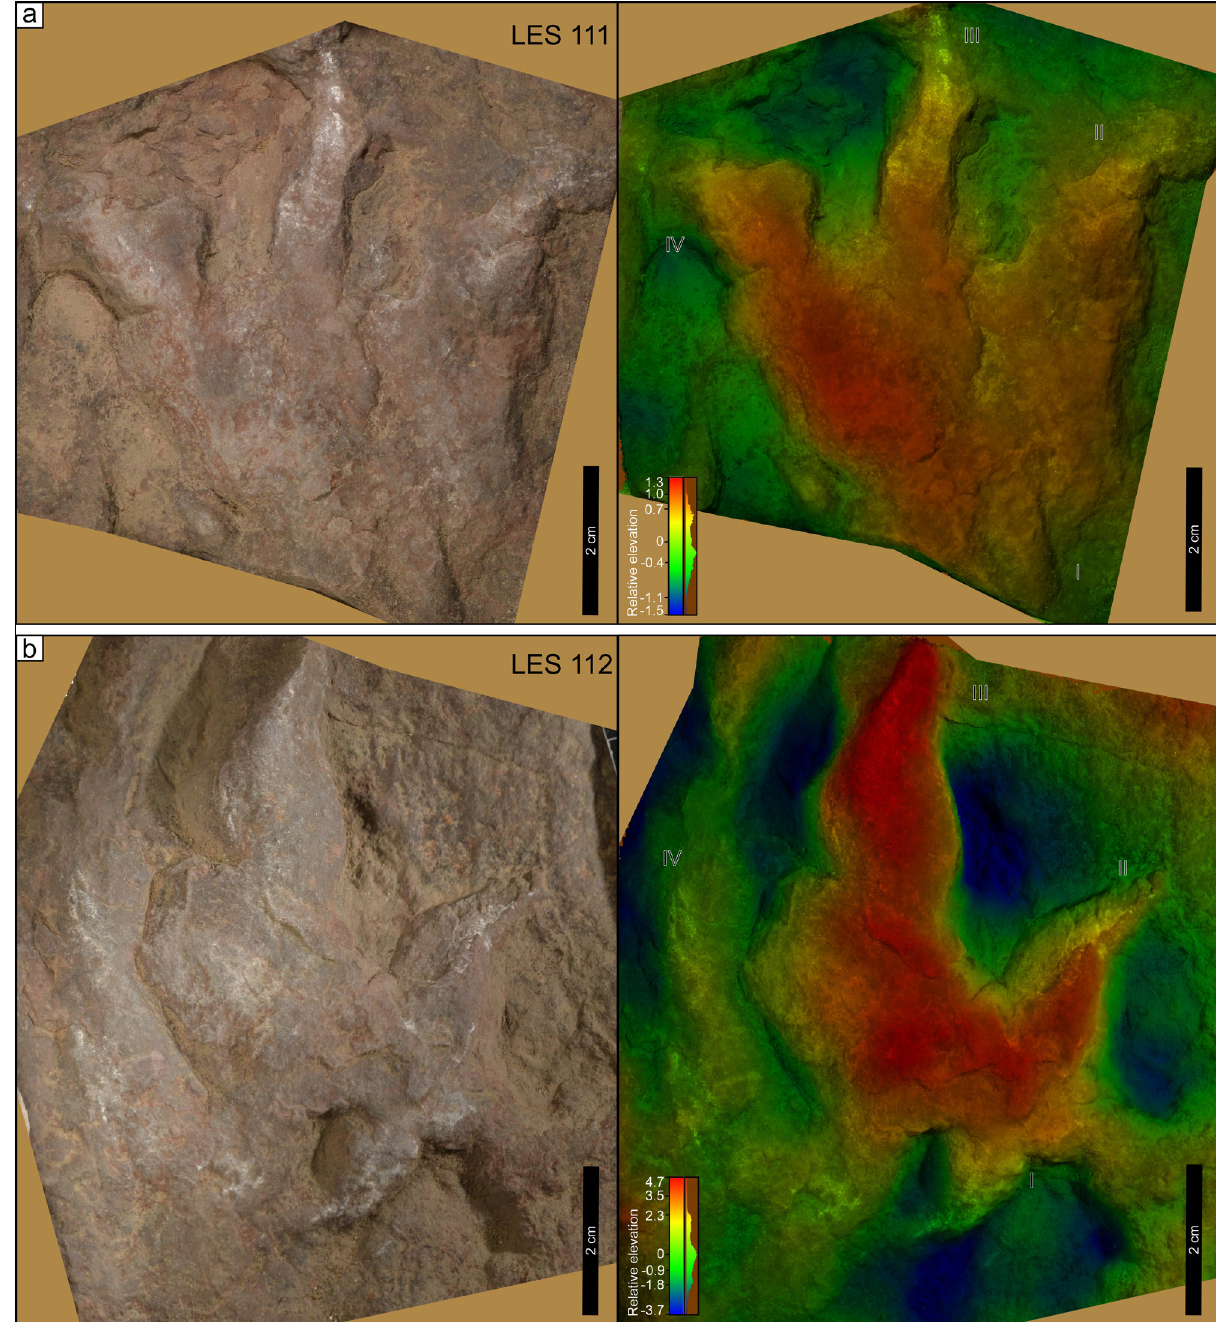
Figure 6: Two examples of small, ~7.7-cm-long tridactyl tracks from the Lower Jurassic of southern Africa. Left image: orthophoto derived from photogrammetric modelling; right image: false-colour depth model generated using CloudCompare version 2.11.3 (dark red is the highest point, dark blue the lowest). (a and b) Masitisisauropus palmipes (LES 111 and LES 112, respectively 38 ) from the lower part of the upper Elliot Formation at Mokanametsong in southwest Lesotho (Quthing district). Compared to these tracks, Grallator tracks are narrower with more slender toe impressions. Both specimens are housed in the Ellenberger Collection at the University of Montpellier (France). See Supplementary table 5 for their morphometric measurements and https://doi.org/10.6084/m9.figshare.13007240 for their photogrammetric models. Roman numerals I–IV denote